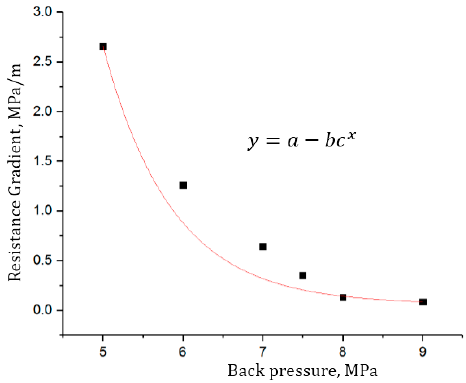
Figure 9. Schematic diagram of fitting results.